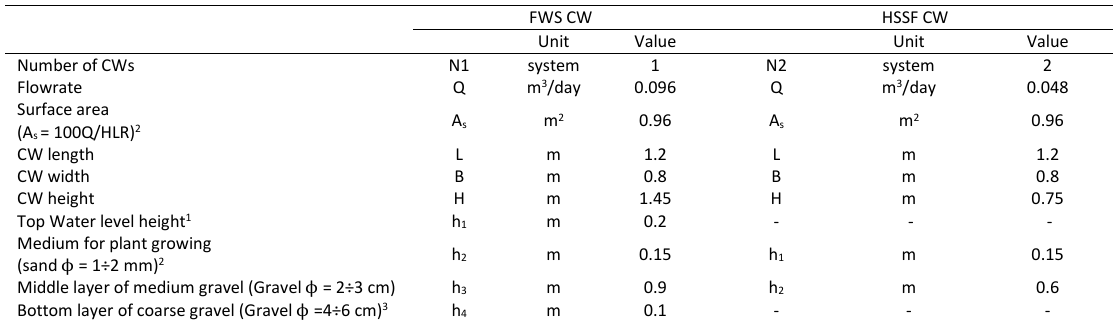
Fig. 2: Experimental pilots installed in wastewater treatment plant in Bach Quang ward Table 1: Descripon of FWS and HSSF CWs Table 1: Description of FWS and HSSF CWs (Watson et al., 1989; Kayombo et al., 2004; USEPA, 2000) (Watson et al., 1989; Kayombo et al., 2004; USEPA,